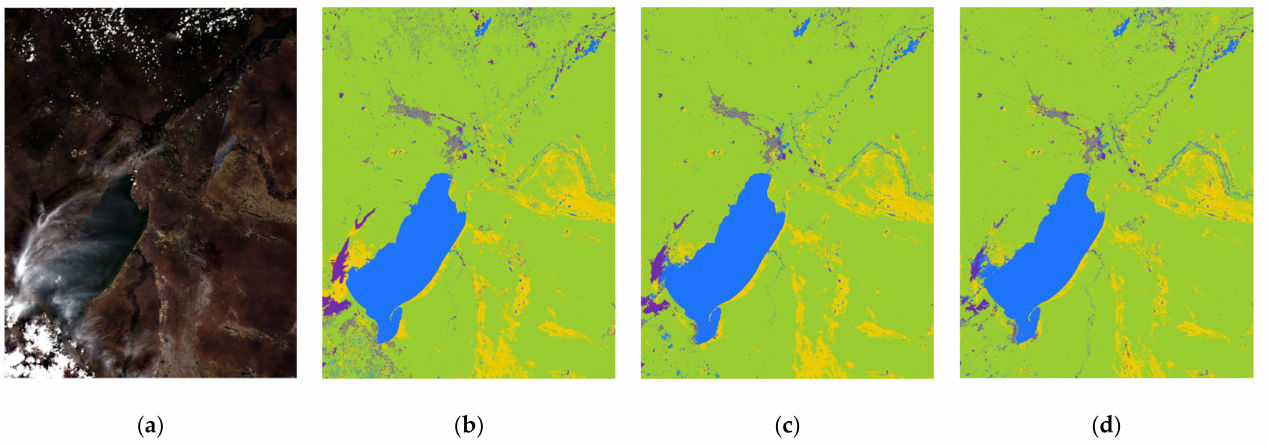
Figure 13. Test results of the whole study area using different data sources and methods. ( a ) Source MS image; ( b ) results without using SAR data; ( c ) results using concatenation; ( d ) results using SK-like